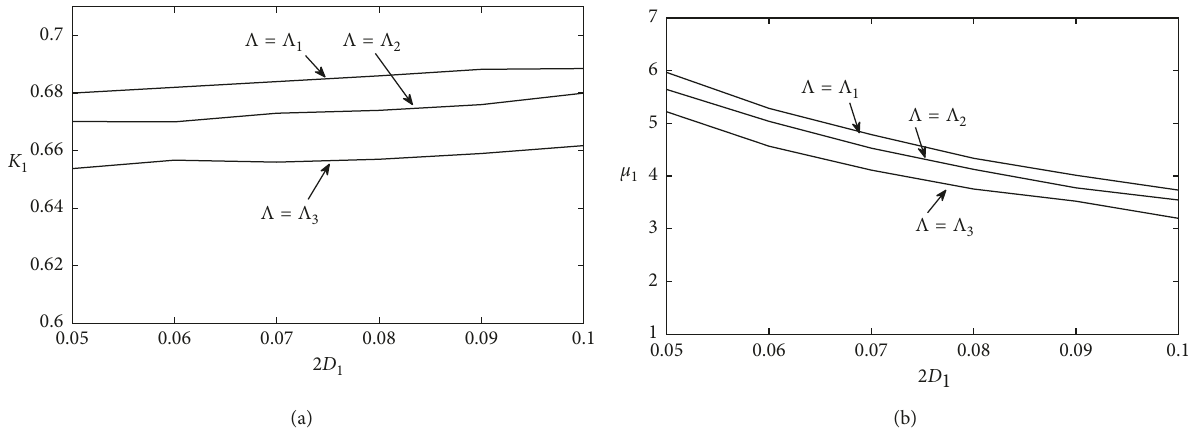
Figure 4: The control effectiveness K